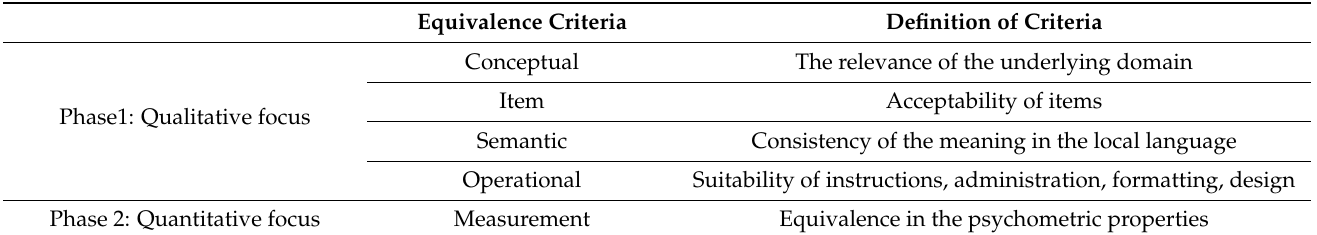
Table 1. Adapted version of Applied Cross-Cultural Equivalence Framework (ACEF) [17].